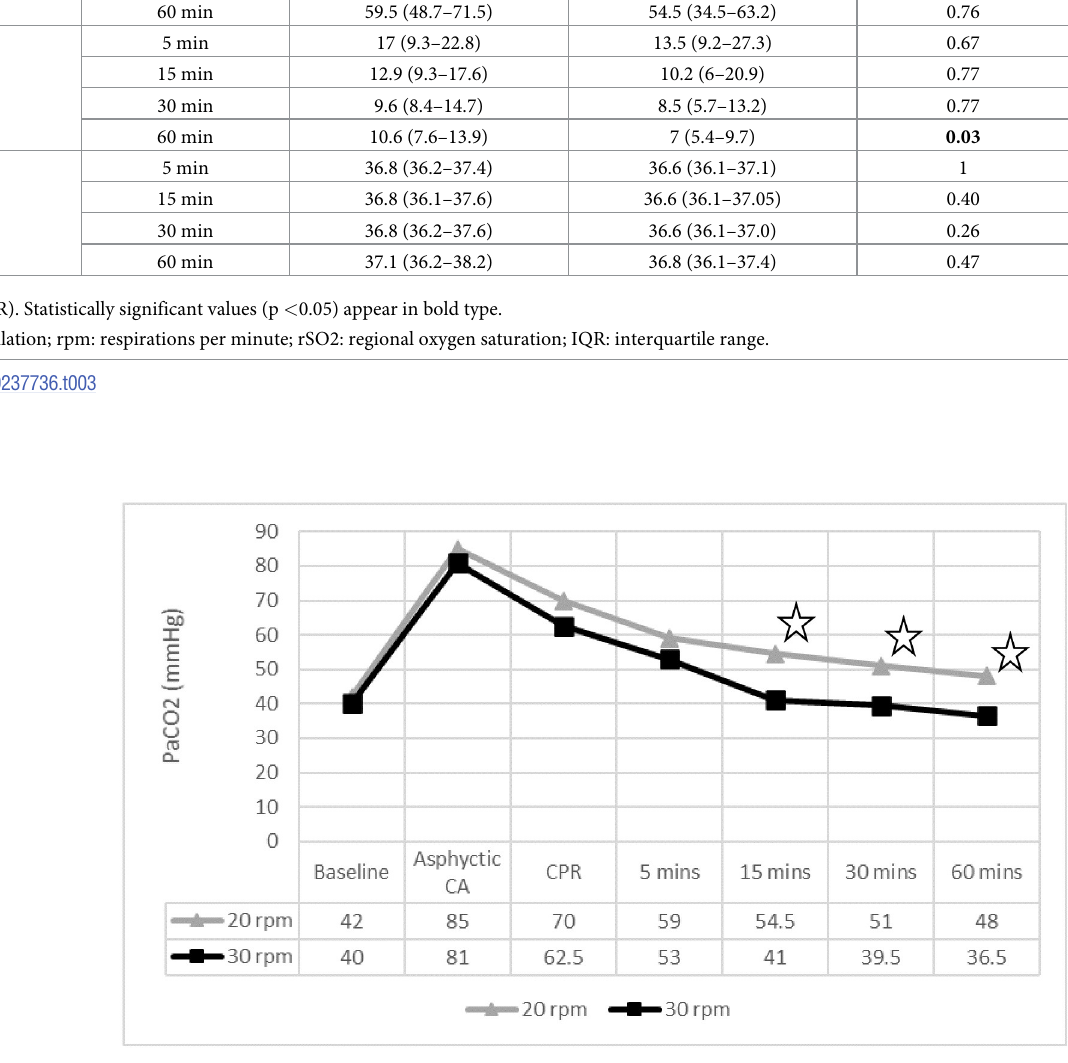
Fig 2. PaCO2 levels throughout the experiment. ✩ p < 0.05. PaCO2: CO2 arterial pressure; CA: cardiac arrest; CPR: cardiopulmonary resuscitation; mins: minutes. 5 mins to 60 mins: time after ROSC.